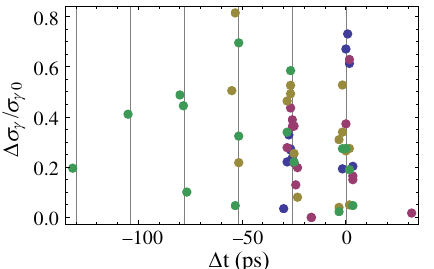
FIG. 8. IFEL energy modulation varying external delay for 6th pass (blue) 8th pass (red) 12th pass (yellow) and 16th pass (green) showing peaks in the IFEL energy modulation at regular time intervals corresponding to the CO 2 rotational line separation (indicated by the vertical lines in the plot). Note that timing was continuously varied, but only electron spectra appreciably differ- ent from the laser-off shots are reported in the